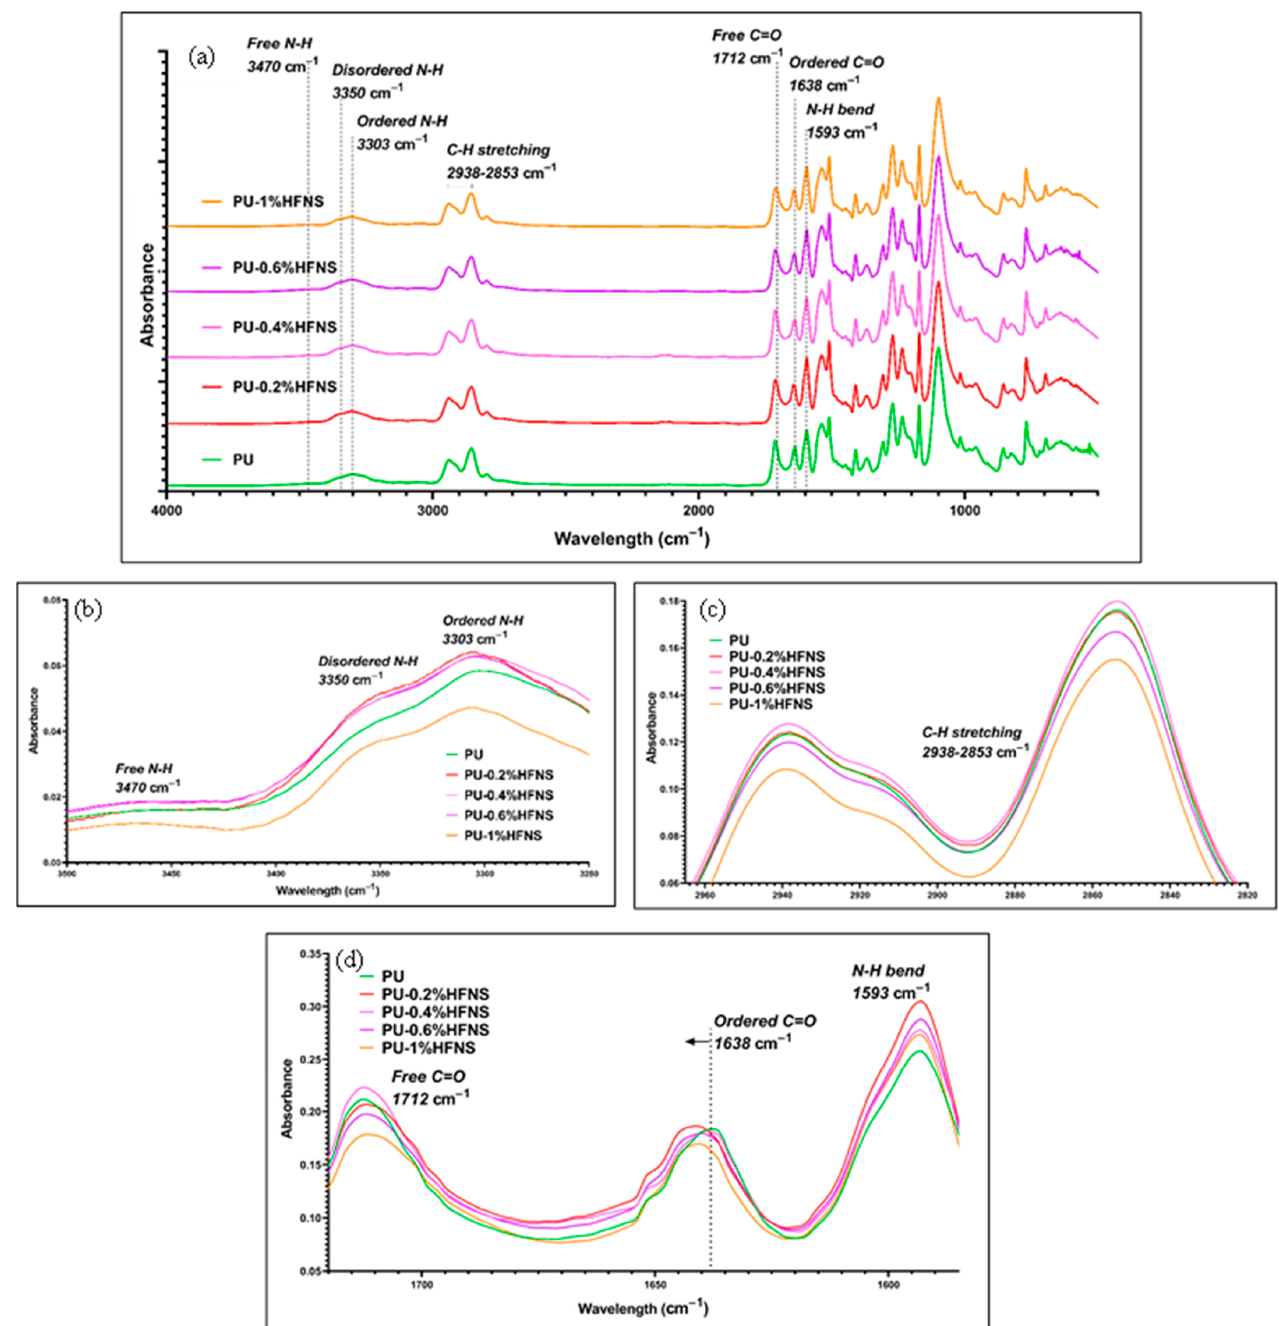
Figure 8. FTIR spectra of ( a ) PU and HFNS nanocomposites films with loadings of 0.2%, 0.4%, 0.6%, and 1%, ( b ) N-H bands, ( c ) C-H bands, and ( d ) carbonyl bands.